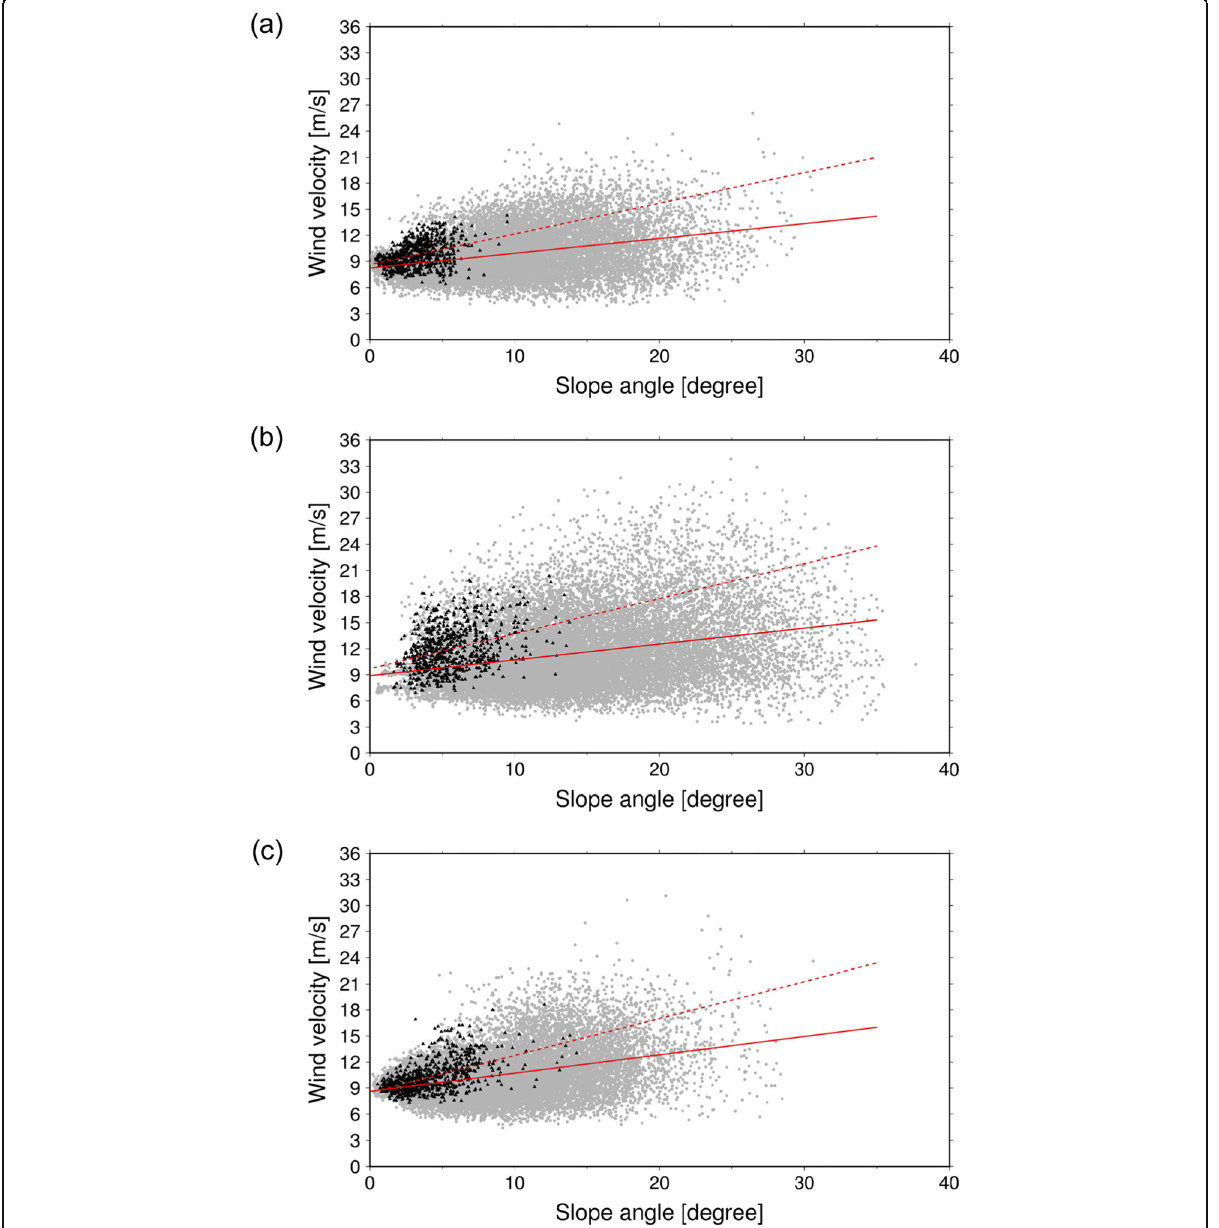
Fig. 6 Relationships between terrain slope and mean wind speed in the analysis areas. Relationships of the temporal mean wind speeds against the terrain slope angle for the 1 km grid case (black dots) and the 200 m grid case (gray dots) in the area ( a ) A, ( b ) B, and ( c ) C. Red solid and dotted lines indicate the linear regression line for the 200 m grid and the 1 km grid case,